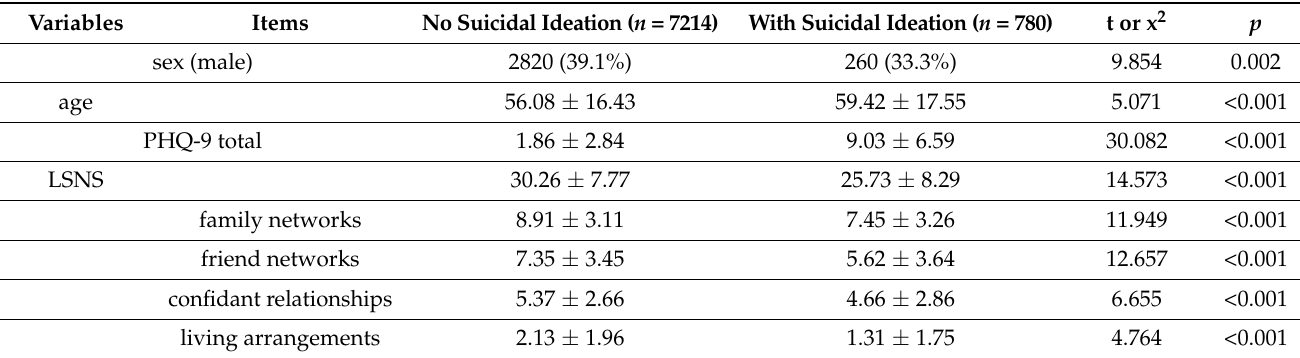
Table 1. General characteristics and differences between